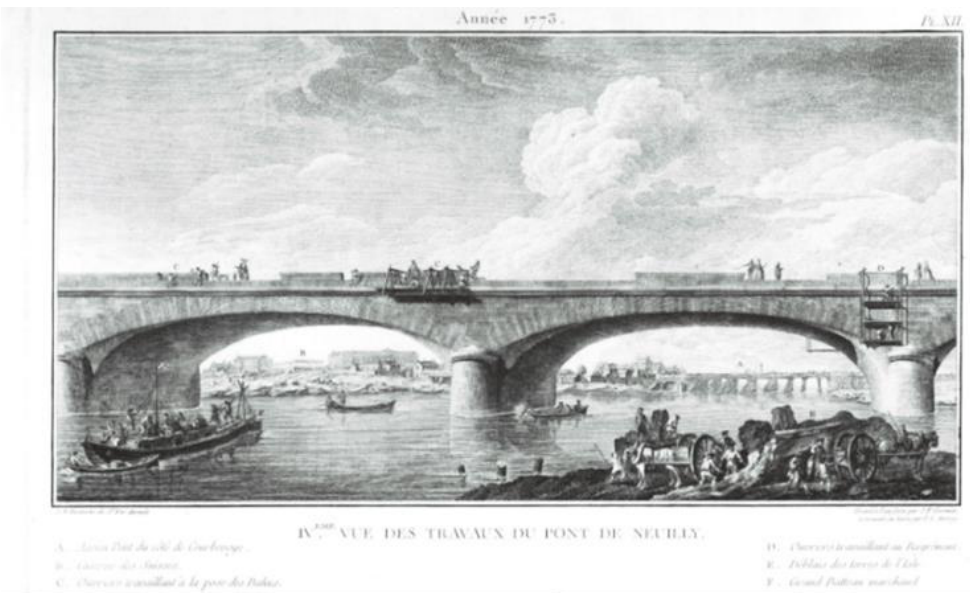
Figure 10. Neuilly Bridge over the Seine. Engraving of the works on the bridge. Main view. Design by Rodolphe Perronet in Neuilly-sur-Seine, France in 1768–1772. Source: Engraving from the municipal archives of Neuilly-sur-Seine.